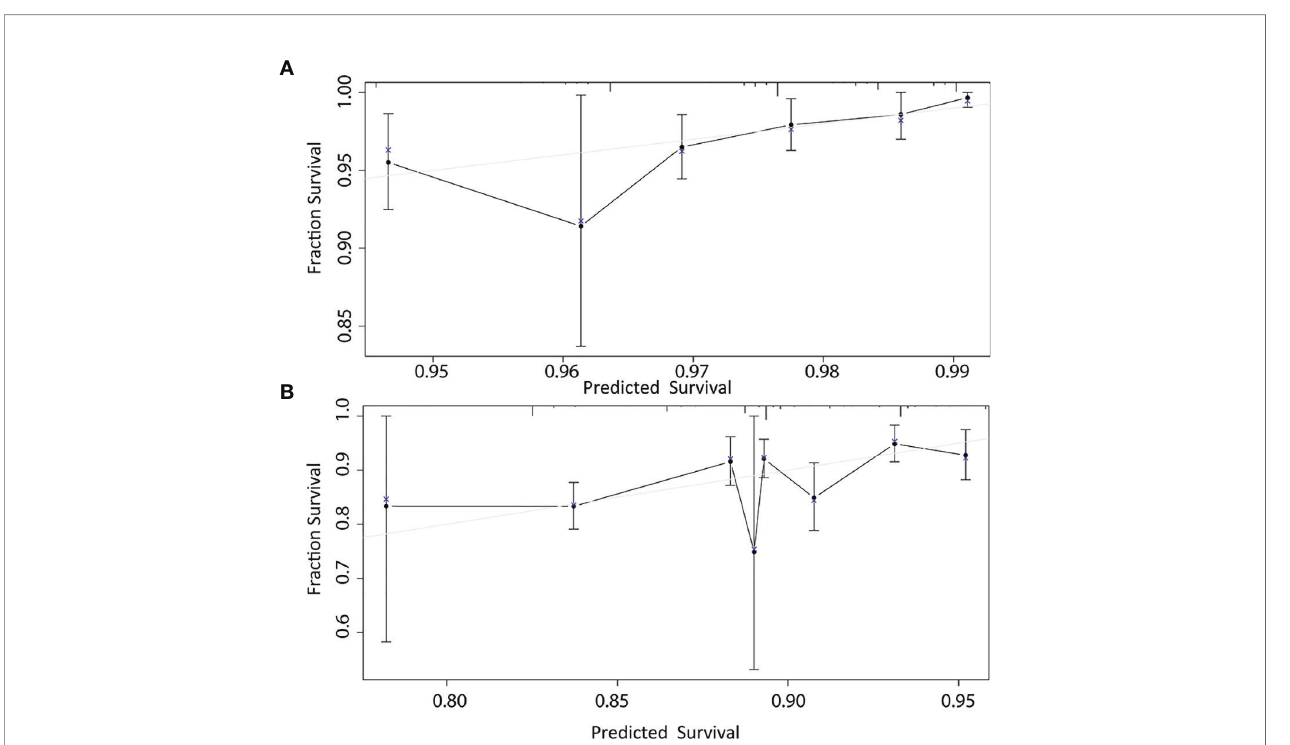
FIGURE 5 | 1000-bootstrap resampling internal veri fi cation correction in 3-year (A) and 5-year (B) for a nomogram of the overall survival in node-negative triple- negative breast cancer patients with tumor size less than 1